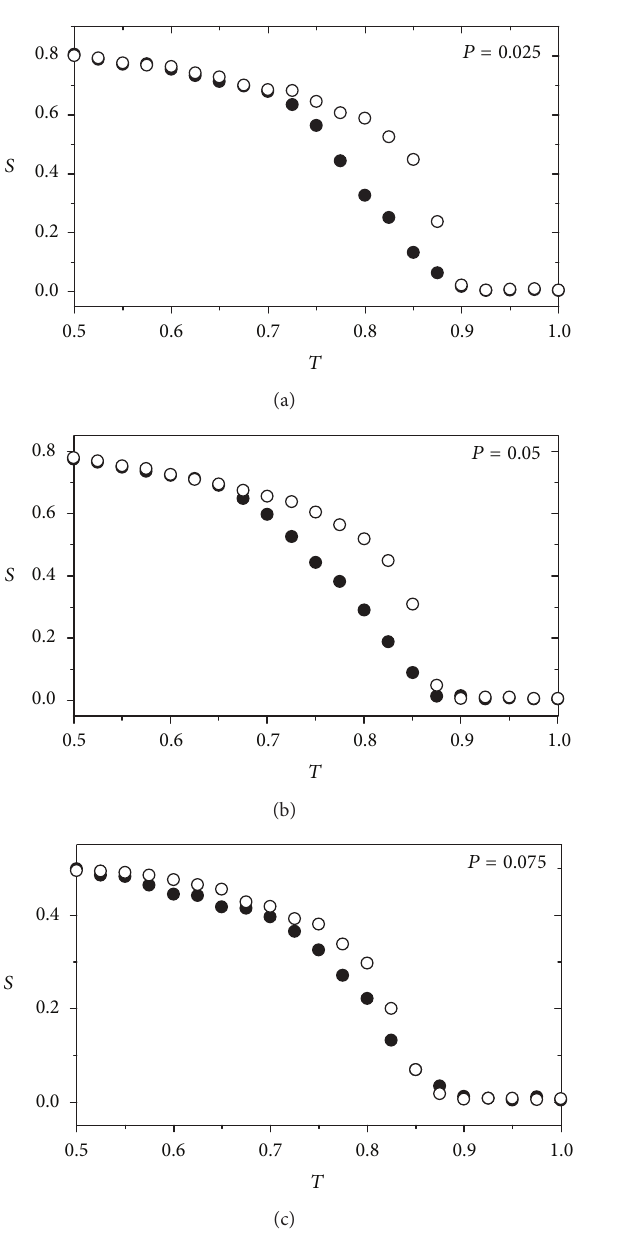
Figure2:Thehystereticbehaviorof 𝑆(𝑇) isshownonincreasingand decreasing 𝑇 in different values of 𝑝 , 𝑊 = 1 , 𝑁 = 60 .